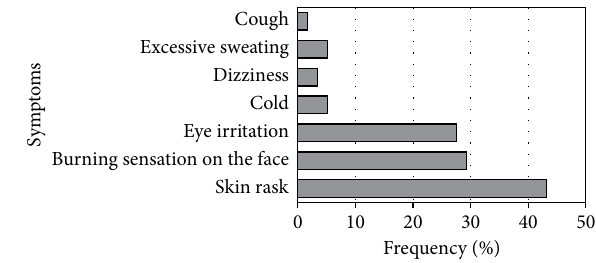
Figure 2: Postapplication symptoms of agropesticide